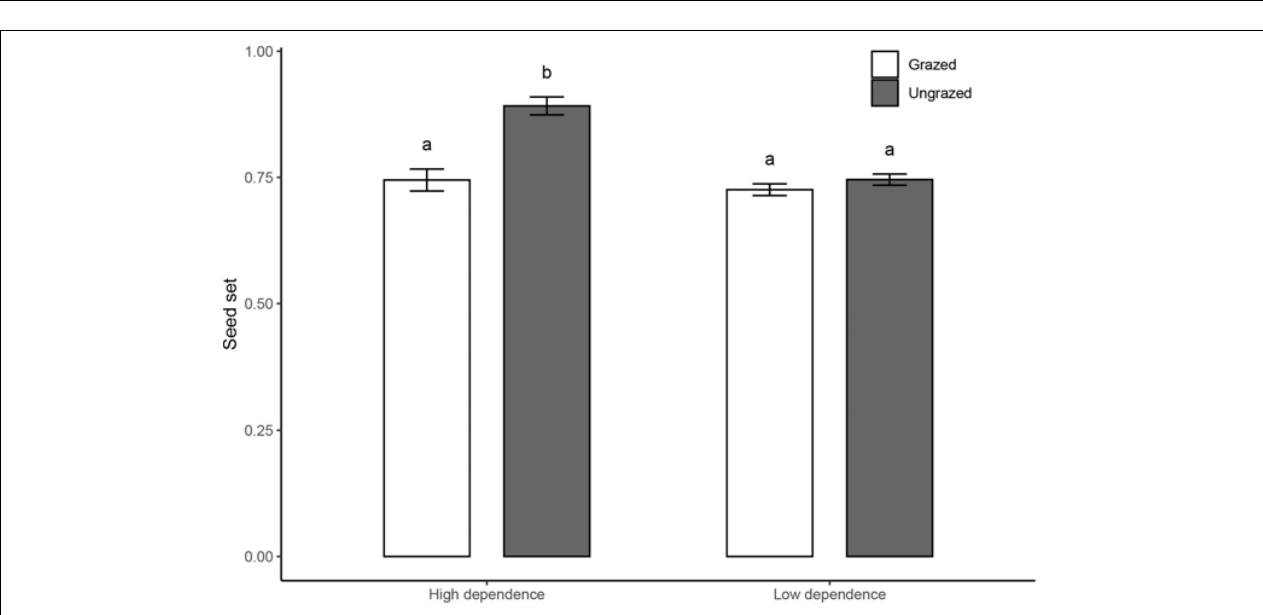
FIGURE 3 | The effects of supplemental pollination on the seed set of two high-dependence (A) and six low-dependence (B) species in grazed and ungrazed habitats. Letters shown above the bar plots indicate the statistical difference between open pollination and supplemental pollination ( P = 0.05).